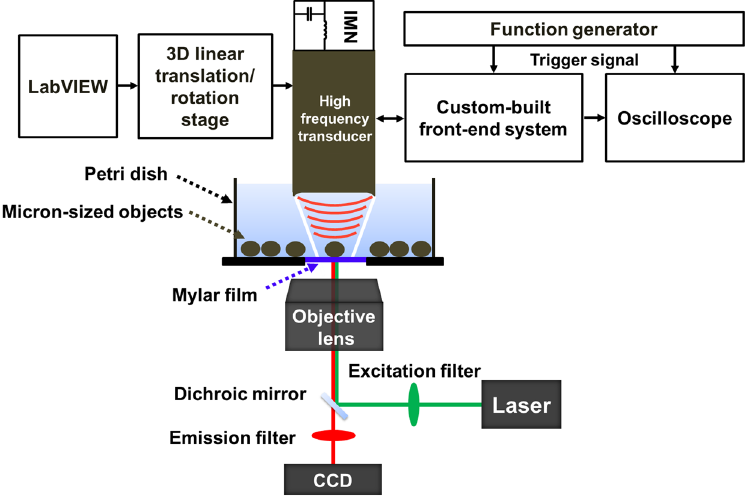
Figure 1. Schematic of developed label-free single-cell analysis system using high-frequency, high-PRF ultrasound microbeam. IMN stands for impedance matching